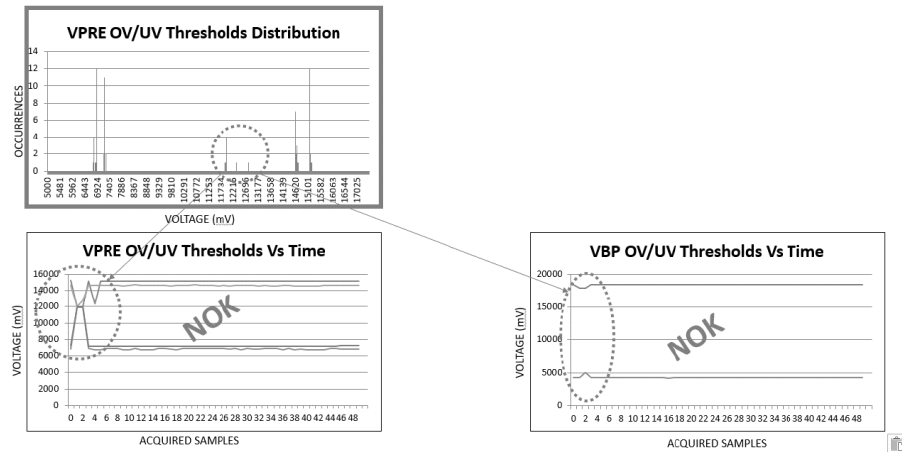
Figure 11. Observation of the anomalous behavior in time.